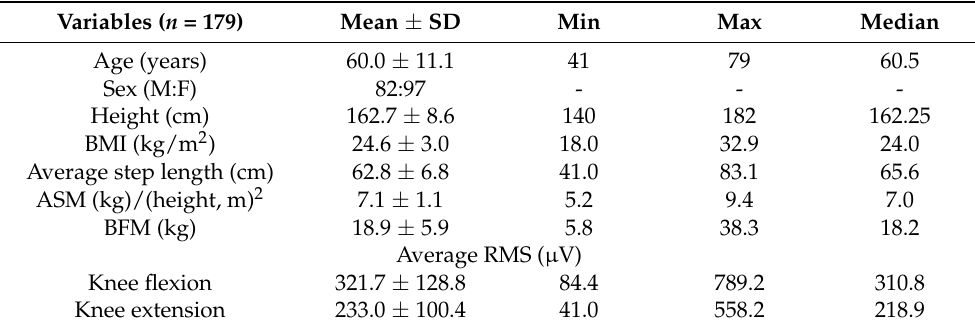
Table 1. Participant demographics and the results of body impedance analysis and surface elec- tromyography measurements.